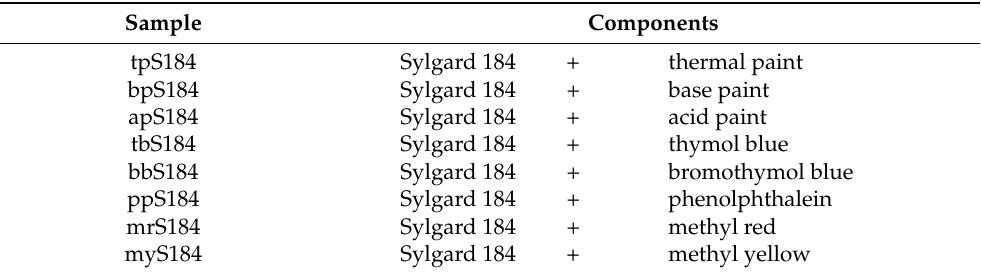
Table 2. Notation of the passive environmental chromophoric sensors used in this study and their